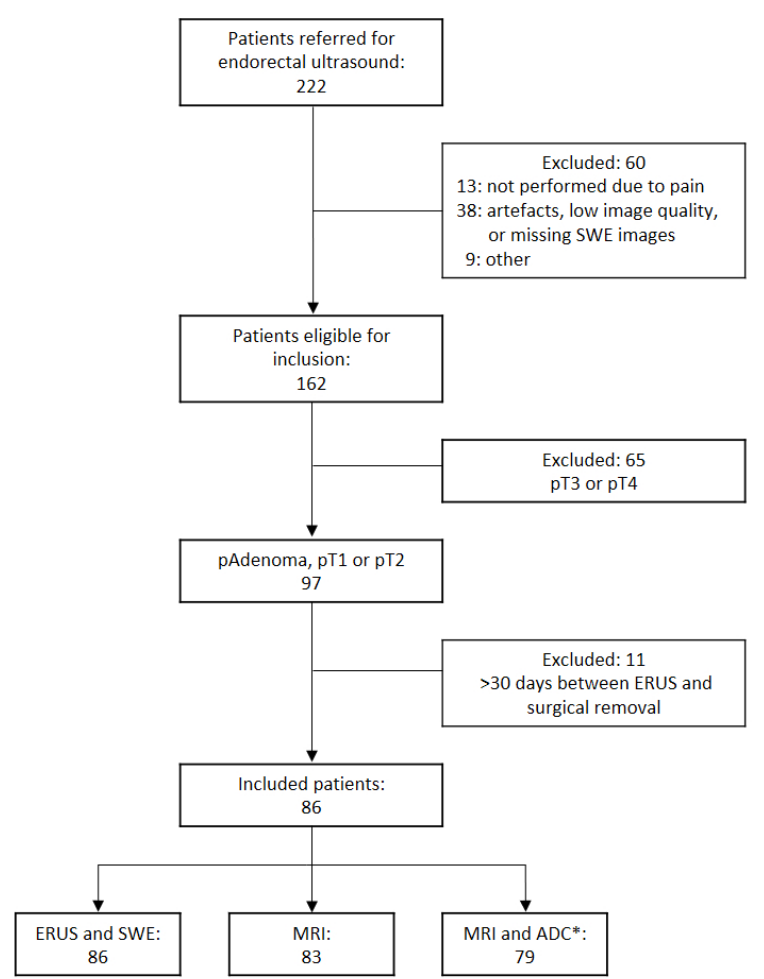
Figure 1. Flow chart of patient inclusion. ERUS: endorectal ultrasound; MRI: magnetic resonance imaging; ADC: apparent diffusion coefficient; * diffusion-weighted imaging was performed in all patients, but four had a hip implant causing artefacts. Table 2. Performance of endorectal ultrasound, magnetic resonance imaging, and shear-wave elas- tography for discrimination between adenoma and early rectal